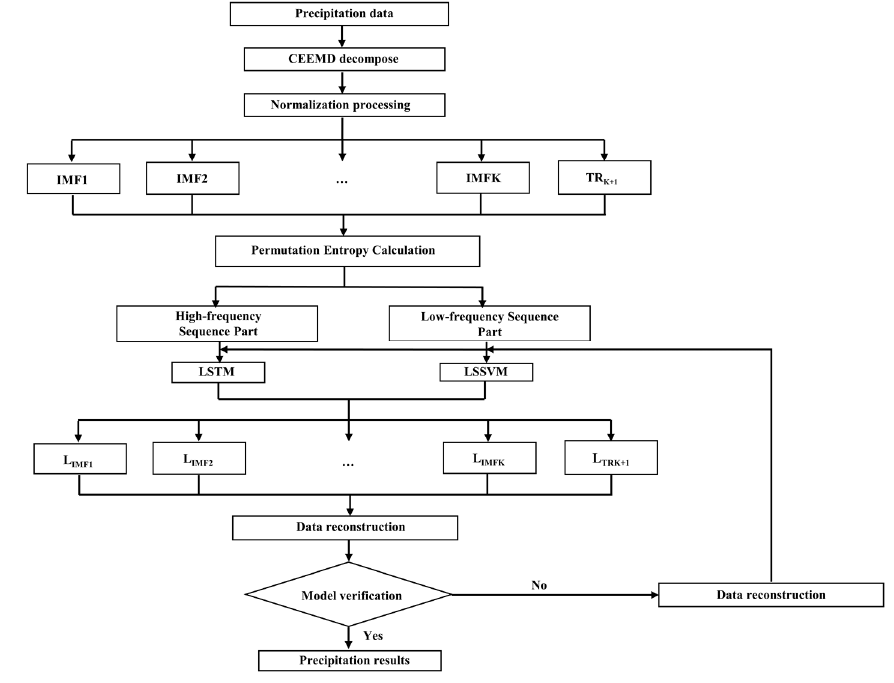
9 of 21 Figure 3. Annual average precipitation distribution in the study area from 1978 to 2022. 4. Model Building 4.1. Modeling Process The study is based on the historical precipitation data of Zhoukou City from 1978 to